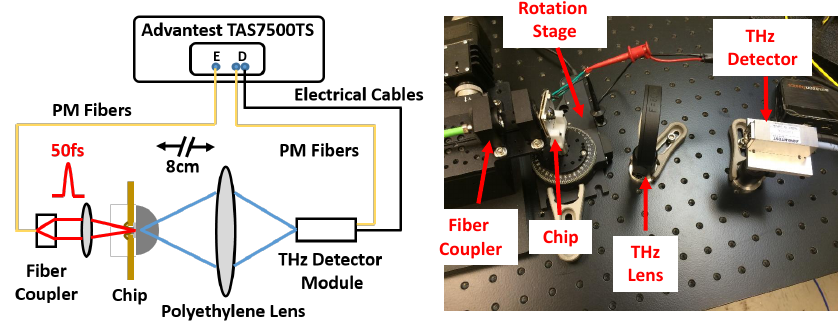
Figure 6. Measurement setup for the prototype THz impulse radiator chip.